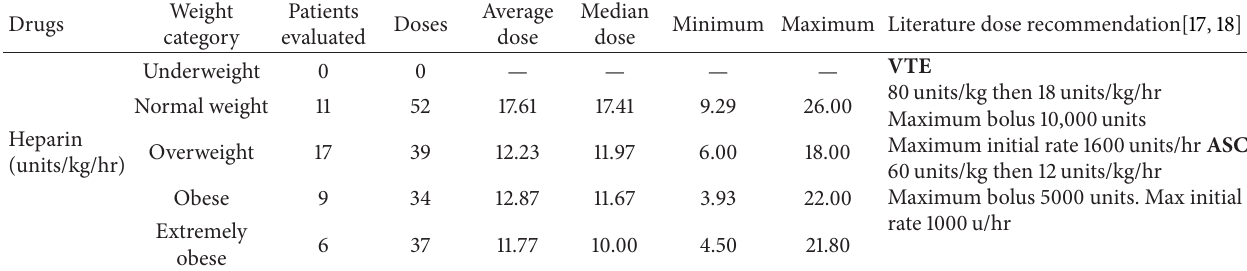
Table 2: Dosing results for heparin by weight category compared to recommendations in the literature.